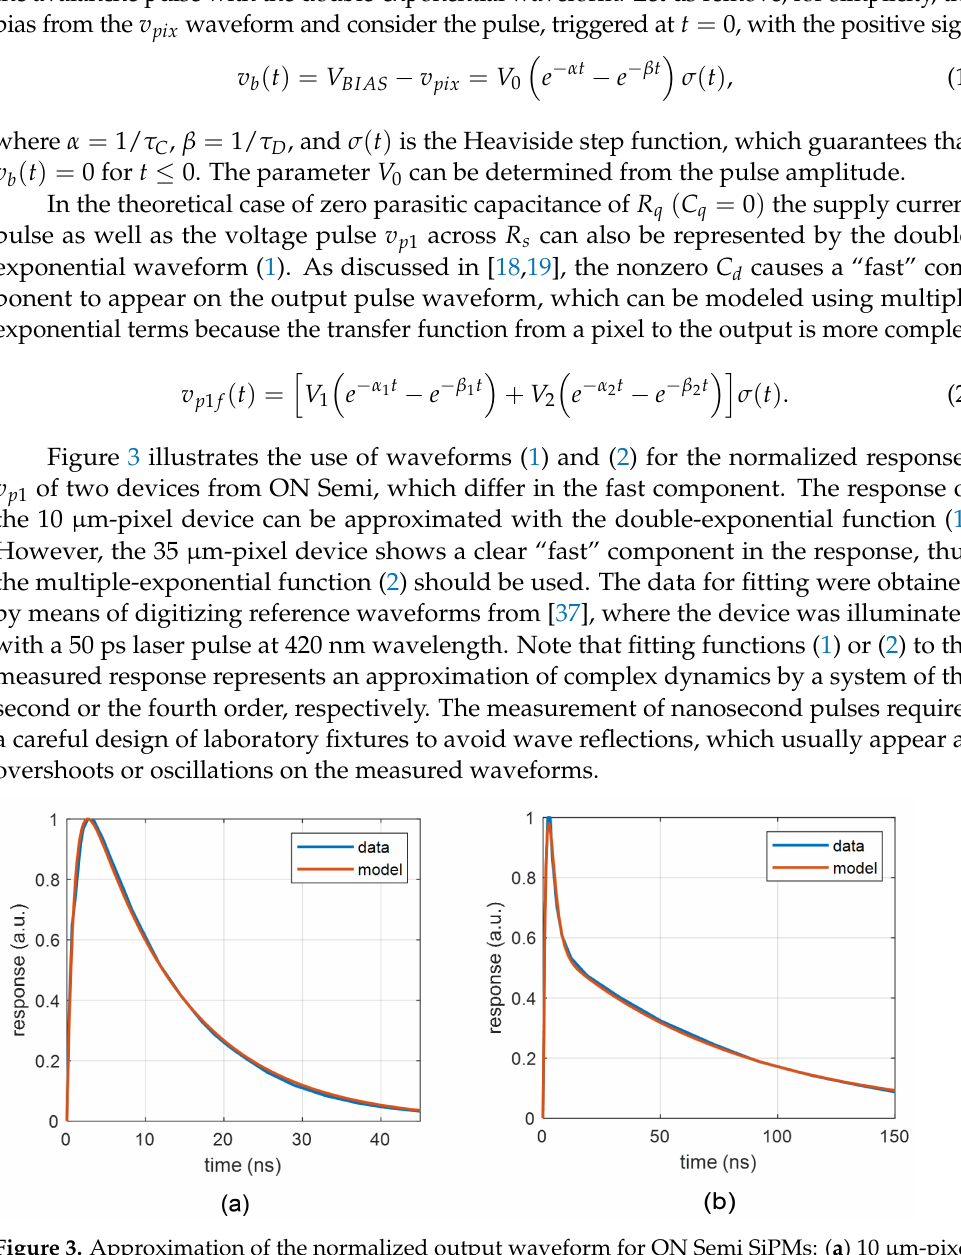
Figure 3. Approximation of the normalized output waveform for ON Semi SiPMs: ( a ) 10 µ m-pixel device (MICRORB-10010) with the double-exponential response (1): V 0 = 1.343, α = 8.076 × 10 7 s − 1 , β = 1.044 × 10 9 s − 1 ; ( b ) 35 µ m-pixel device (MICRORB-10035) with the fast component and multiple-exponential approximation (2): V 1 = 0.5896, α 1 = 1.233 × 10 7 s − 1 , β 1 = 0.4610 × 10 9 s − 1 , V 2 = 11.096, α 2 = 0.5069 × 10 9 s − 1 , β 2 = 0.5914 × 10 9 s − 1